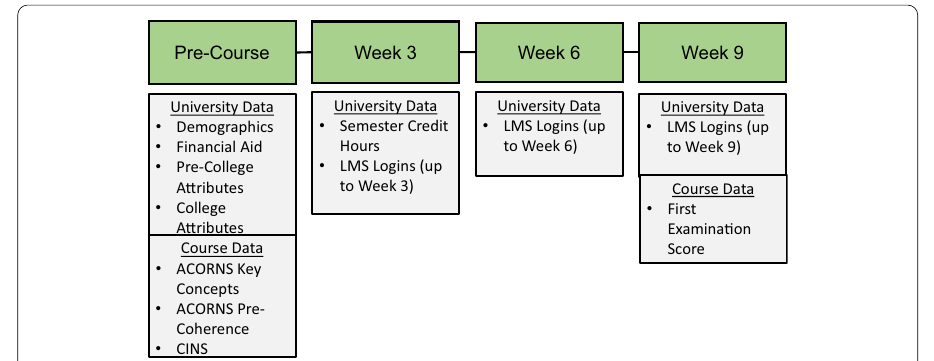
Fig. 3 Features introduced at each time frame. Features are incrementally aggregated with those from prior time intervals